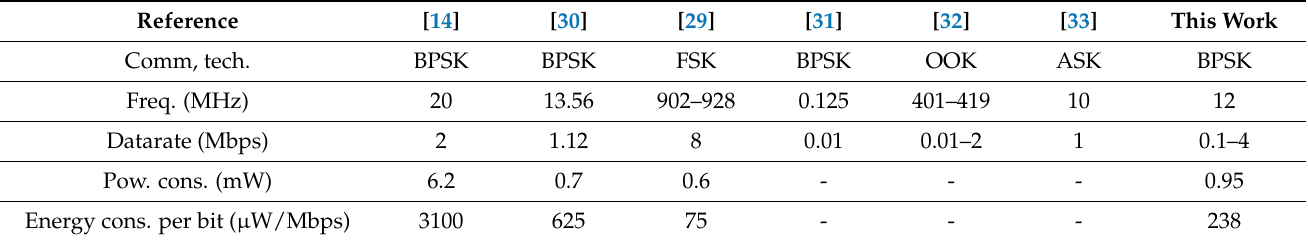
Table 2. Comparison with other biomedical